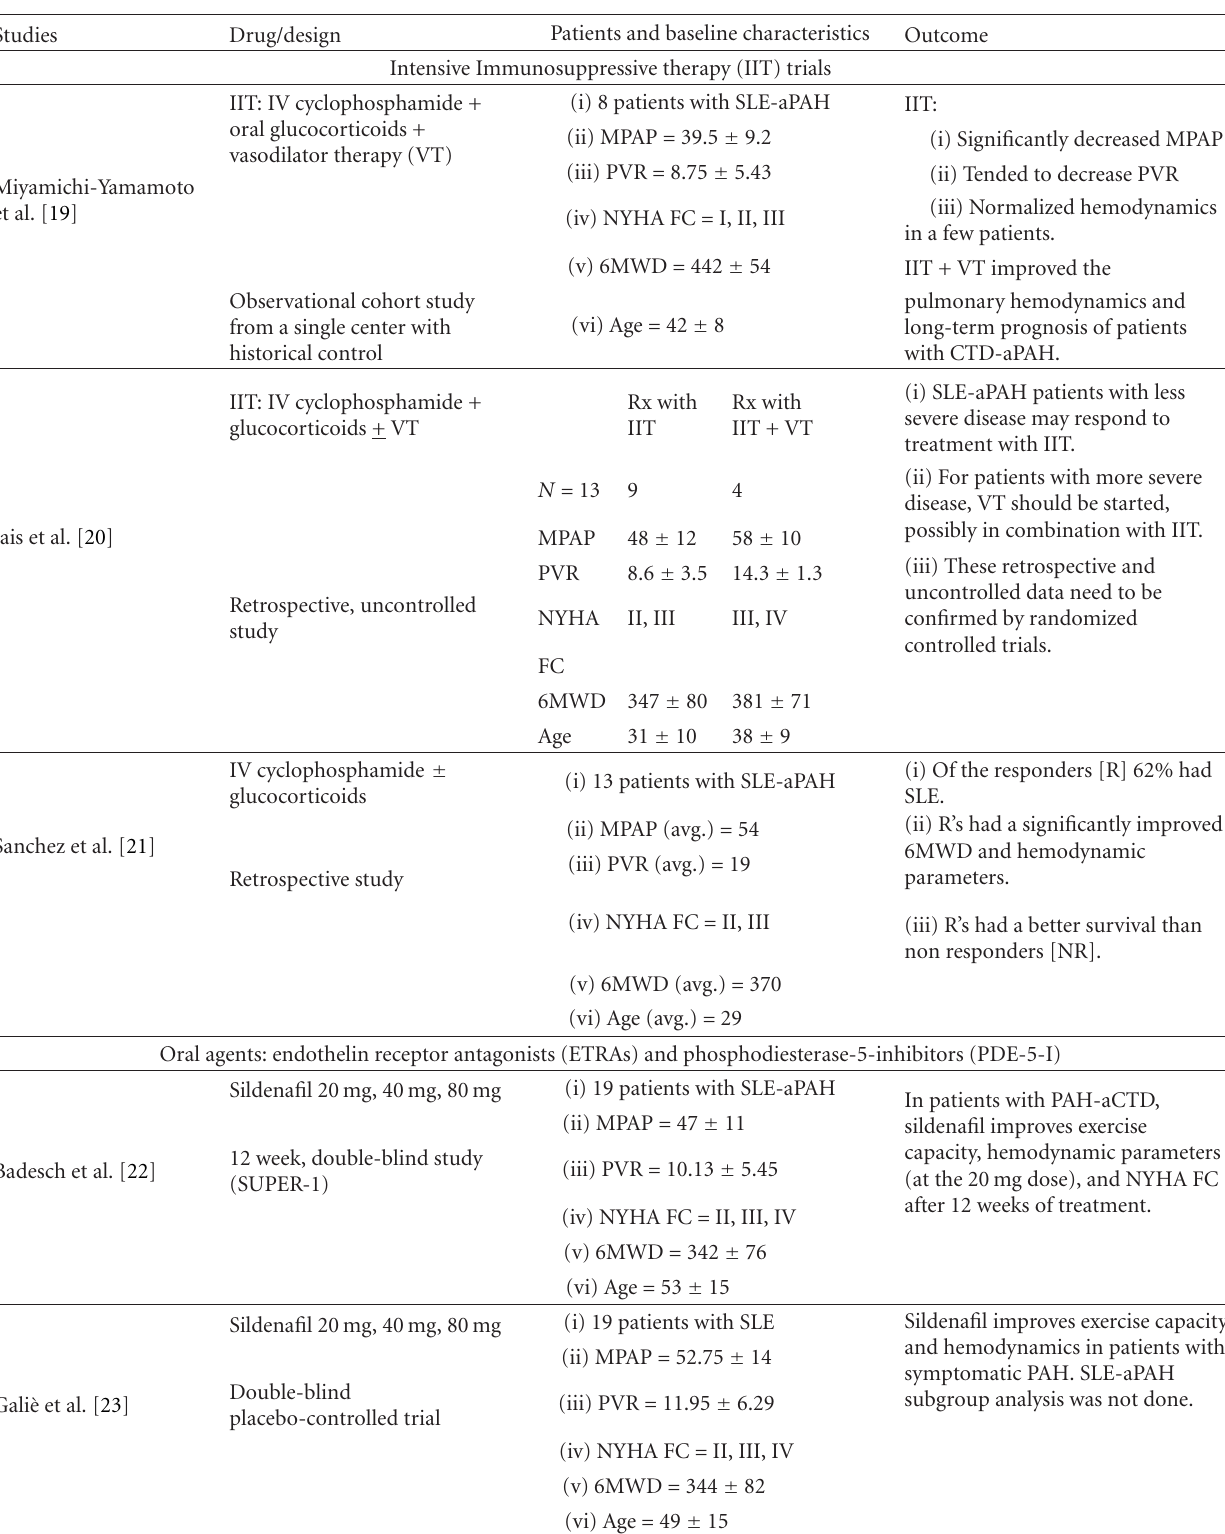
Table 5: Treatment modalities and respective outcomes for SLE-aPAH patients. Mean pulmonary artery pressure (MPAP) in mmHg; pulmonary vascular resistance (PVR) in Woods units; 6 minute walk distance (6MWD) in meters; age in years; New York Heart Association Functional class (NYHA FC); Average